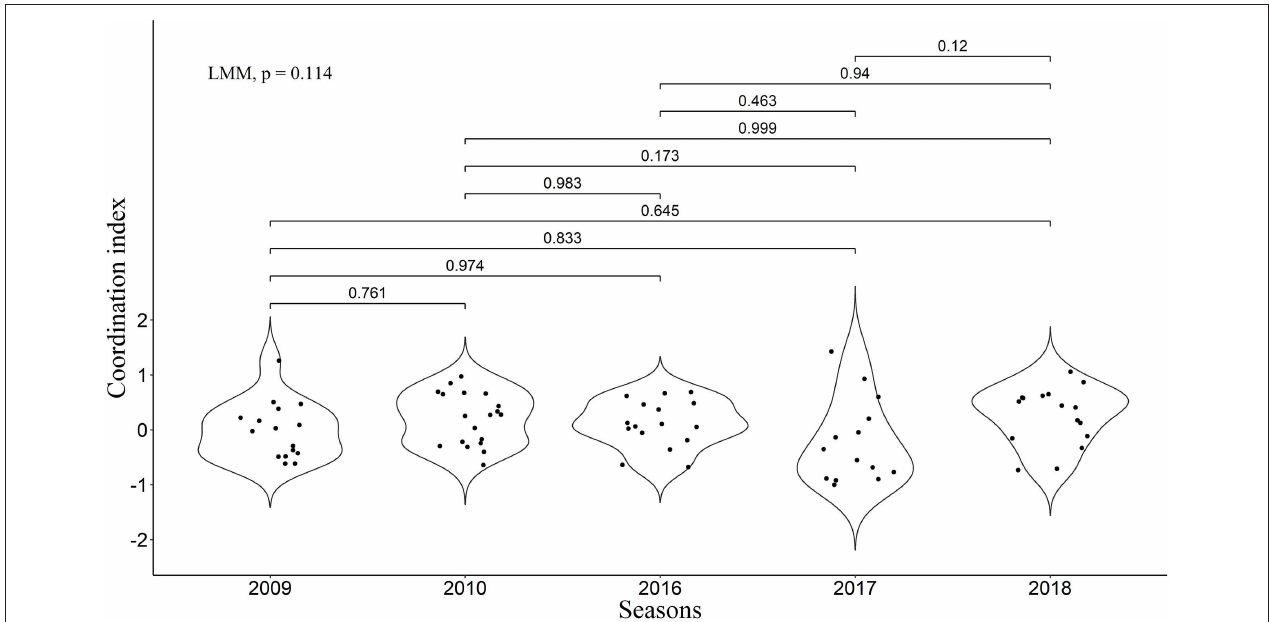
FIGURE 2 | Coordinated index for all five seasons. Violin plots represent the distribution. P -values from inter-season comparisons made with Tukey tests are presented above the lines. Overall differences were statistically tested with linear mixed modeling. Positive values are associated with apparent coordination in the sense we consider in the present study (i.e., avoiding overlap of LTs by the two partners), and values equal to 0 or negative correspond to an absence of this type of coordination.